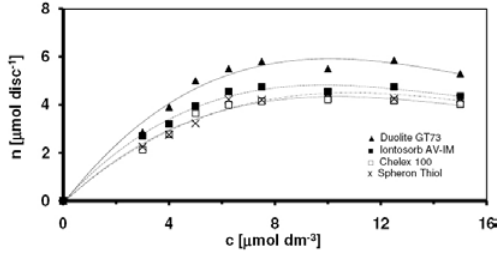
Figure 1. Sorption isotherms of all tested sorption